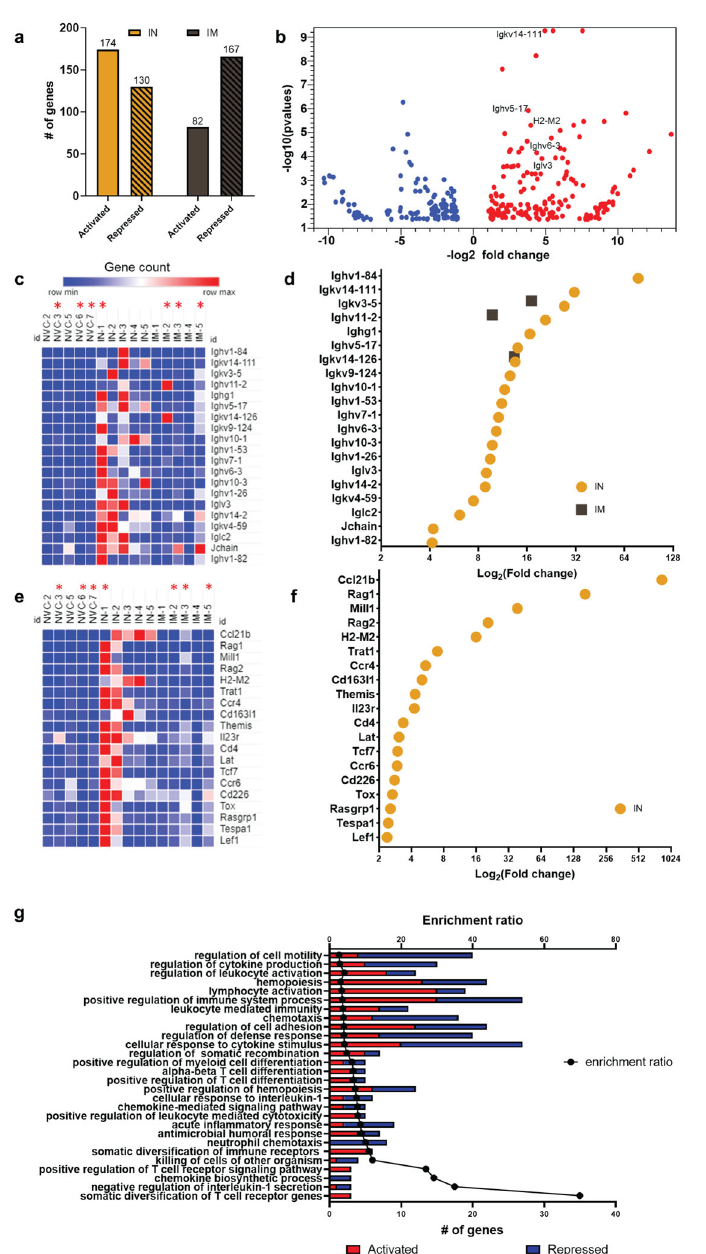
Fig. 9 RNAseq analysis reveals IN BReC-CoV-2 vaccination results in unique gene expression signatures enriched for T cell responses. All analyses were performed on CLC genomics workbench 21. a Number of signi fi cant (FDR p < 0.05) activated and repressed genes in IN BReC- CoV-2 and IM BReC-CoV-2 groups. b Volcano plot indicating signi fi cant gene expression pro fi le of IN BReC-CoV-2 compared to NVC. Red circles denote upregulated genes and blue circles represent downregulated genes. c Heat maps were generated by Morpheus. Heat map represents gene counts of immunoglobulin genes in each mouse lung. d Signi fi cant fold changes of the immunoglobulin genes of interests in both IN and IM BReC-CoV-2 groups. e Heat maps were generated by Morpheus. Heat map represents gene counts of adaptive immune response genes of interest in the mouse lung. f Signi fi cant fold changes of adaptive immune response genes in both IN and IM groups. IM BReC-CoV-2 did not have signi fi cant fold changes. Red asterisks next to the sample ID indicate mouse morbidity before the termination of the study. NVC3 and IN1 euthanized on day 6, IM5 euthanized on day 7, IM3 euthanized on day 8, IM2 euthanized on day 9, and NVC6 and 7 euthanized on day 10. g Gene set enrichment analysis of IN BReC-CoV-2 compared to NVC was performed on WEB-based Gene SeT AnaLysis Toolkit. The enrichment ratio of signi fi cant GO-terms compared to the number of genes in each enriched gene set. Red represents activated genes and blue represents repressed